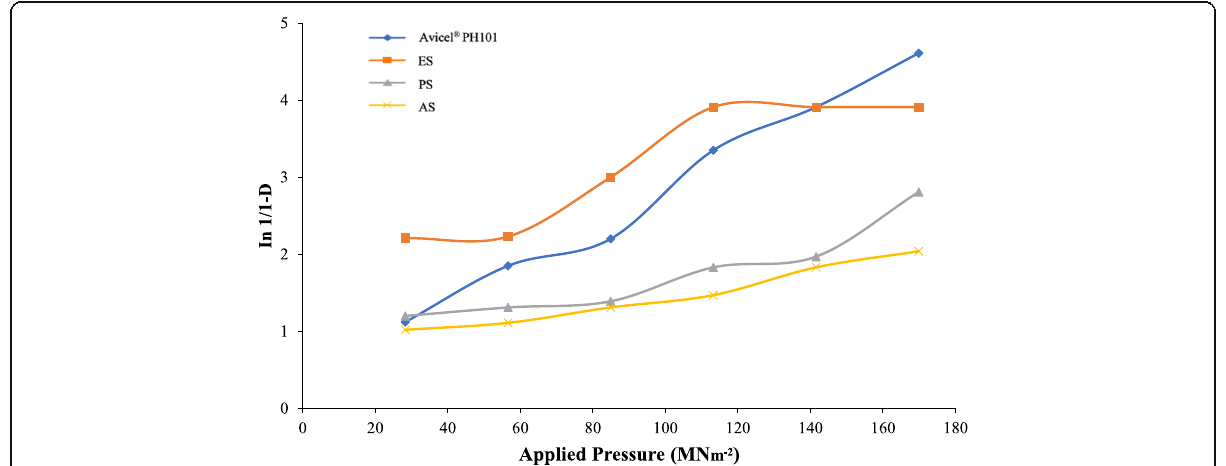
Fig. 2 Heckel profiles for modified starches (ES, PS, AS) and Avicel® PH101 of compact excipients as